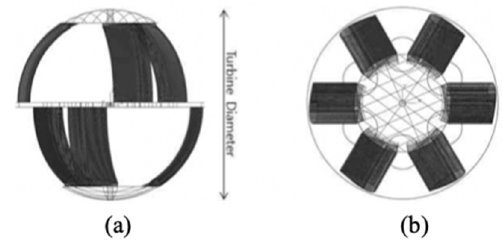
Figure 2. Turbine design: ( a ) side view and ( b ) top view.